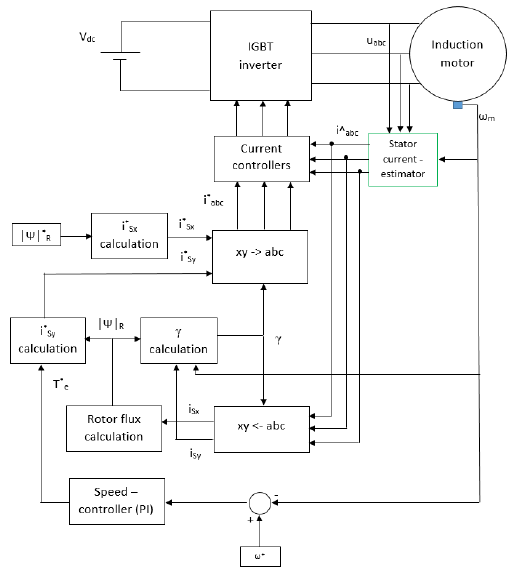
Fig. 3. Block diagram of the HPWM technique without current sensors. Fig. 3: Block diagram of the HPWM technique without The dynamic model of an induction motor in the α-β coordinate system can be described as the following expressions: current